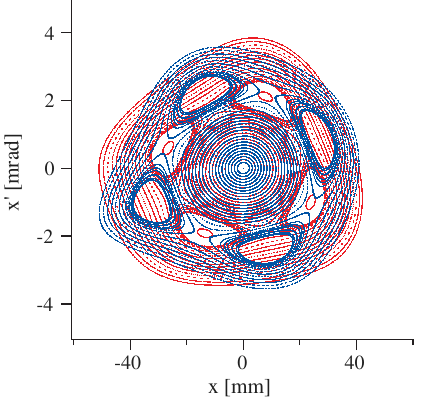
FIG. 6. Superposition of the transverse phase space correspond- < 0 (red) and a tune of ing to a horizontal tune of 6.255 and h 2 ; 0 > 0 (blue). In both cases no intensity-dependent 6.245 and h 2 ; 0 effects are taken into account.